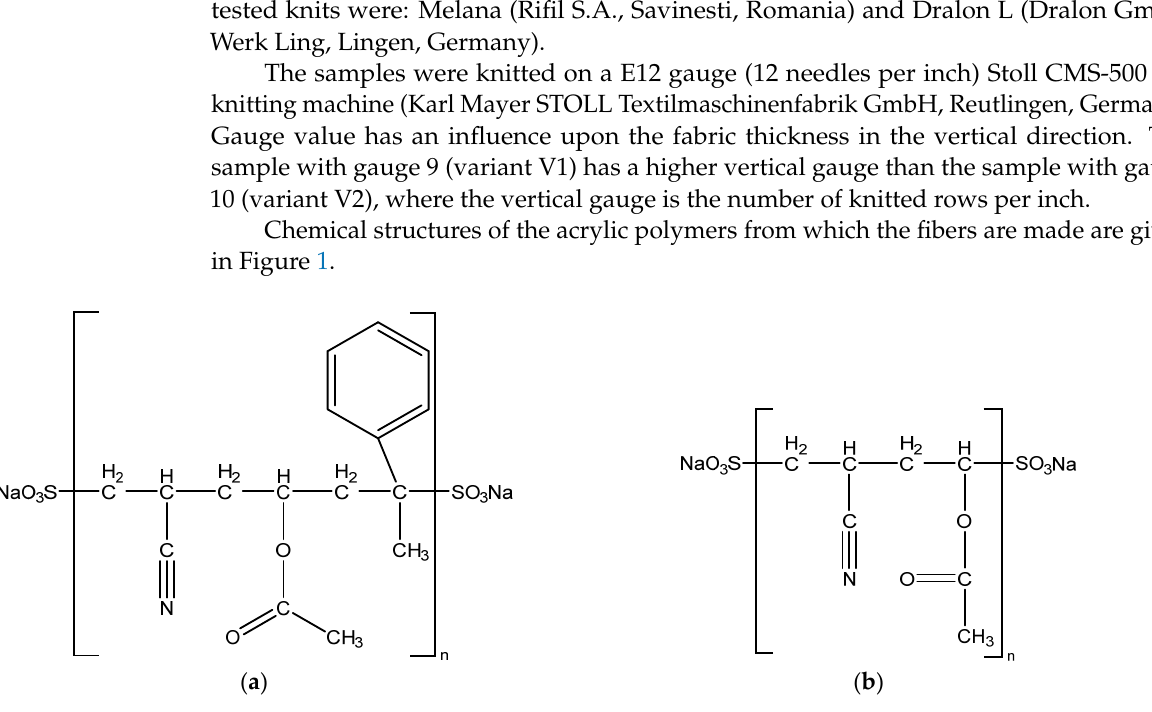
Figure 1. Chemical structures of the investigated acrylic polymers: ( a ) “Melana”; ( b ) “Dralon L”. Other names for Dralon L: vinyl acetate/acrylonitrile copolymer and vinyl acetate/ac- rylonitrile polymer.